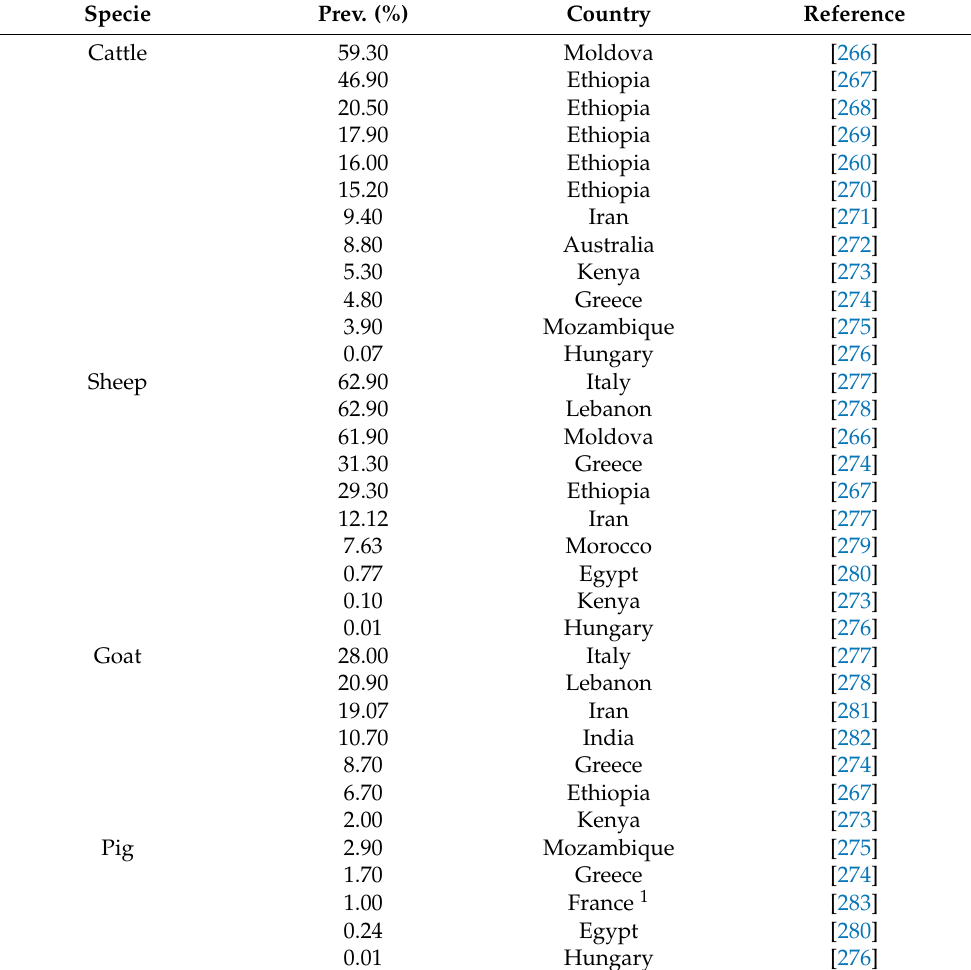
Table 9. Hydatidosis prevalence at